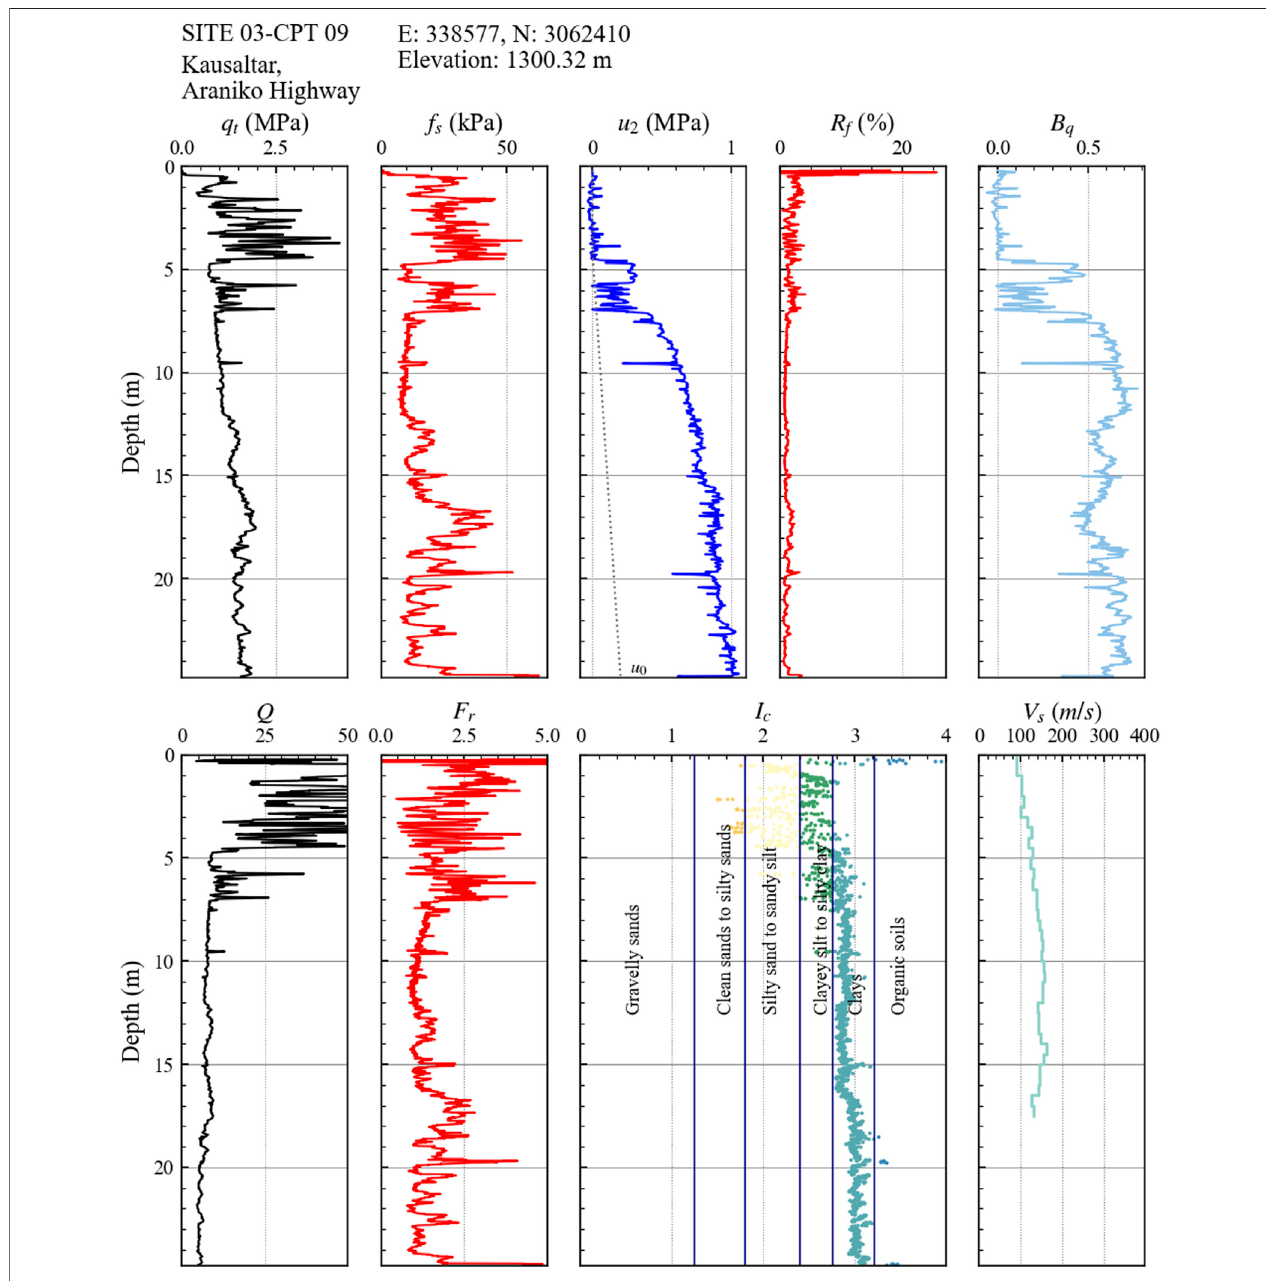
FIGURE 5 | CPT results at site 03,